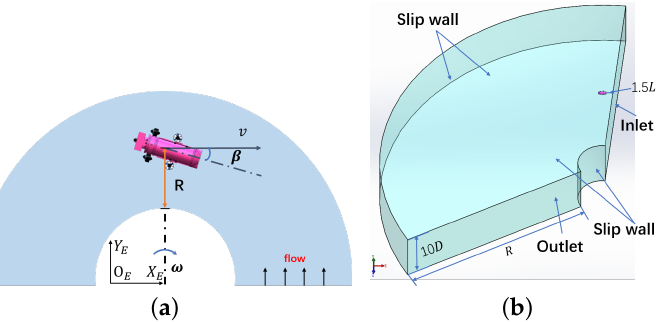
Figure 8. ( a ) Schematics for the rotating arm test of the underwater vehicle. ( b ) Computational fluid domain designed for the rotating arm test simulation.